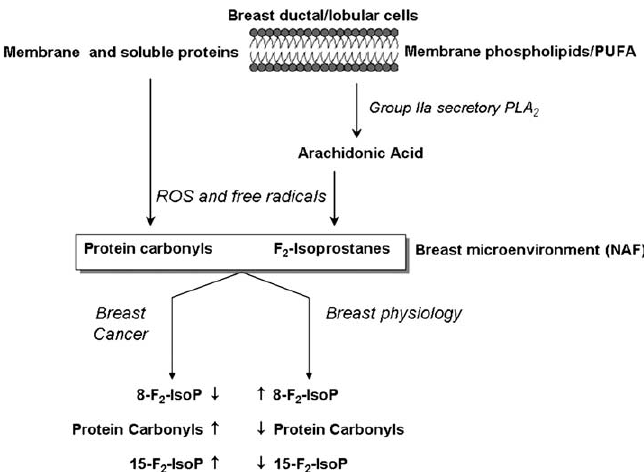
Fig. 4. Hypothetical scheme representing the involvement of protein and lipid oxidation biomarkers in breast physiology and cancer initia- tion/progression. Under physiological conditions, breast apocrine cells lining ducts and lobules release arachidonic acid from membrane phos- pholipids through the action of phospholipase A 2 . Both arachidonate and membrane/soluble proteins may be modified by reactive species of oxygen and free radicals, leading to the formation of protein carbonyls and F 2 -isoprostanes that may accumulate in the breast tissue microen- vironment (as reflected in nipple aspirate fluid). At this point either of two pathways may occur: (1) in women without evidence of cancer and during breast physiological processes (such as lactation), high levels of 8-isoprostanes may be present in NAF; in the presence of normal/high levels of natural endogenous anti-oxidants, 8-isoprostanes are not oxidized to 15-isoprostanes (the end-stage of lipid peroxidation); in the same way, proteins are not significantly oxidized to carbonyls. (2) In breast cancer conditions, low levels of endogenous antioxidants and increased oxidative stress may enhance the further oxidation of 8-isoprostanes leading to significant accumulation of 15-isoprostanes, favouring oxidative modifications of proteins and carbonyl formation. (PUFA: polyunsaturated fatty acid; PLA 2 : phospholipase A 2 ; ROS: reactive species of oxygen; NAF: nipple aspirate fluid; IsoP: